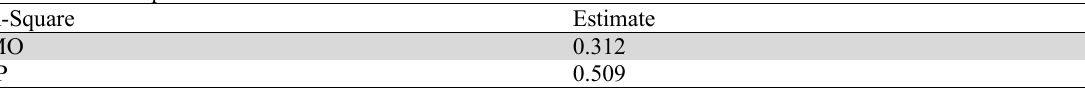
The results of R-Square